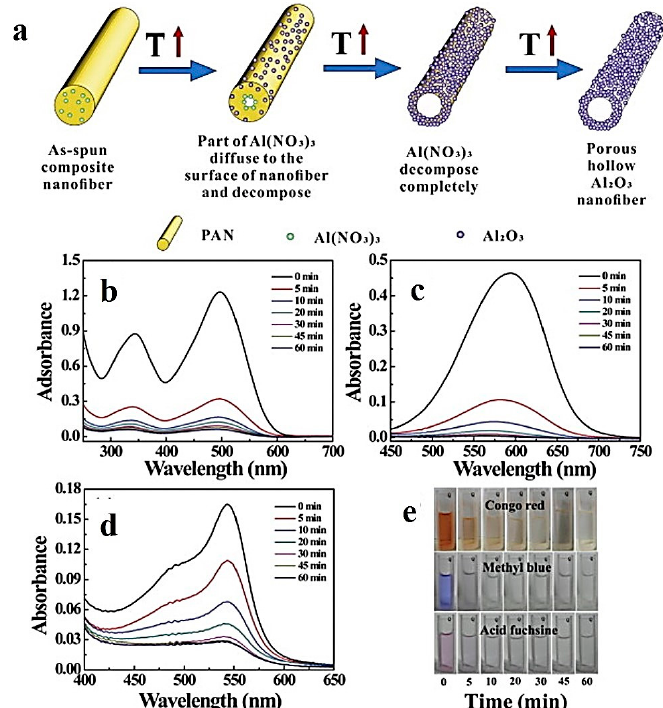
Figure 12. ( a ) The schematic shows different steps of the formation process of the porous hollow γ -Al 2 O 3 nanofibers; ( b – d ) UV–vis spectra of congo red (CR) ( b ) methylene blue (MB) ( c ), and acid fuchsine (AF) ( d ) in proximity of the porous hollow γ -Al 2 O 3 nanofibers after 0, 5, 10, 20, 30, 45, and 60 min, respectively. ( e ) Camera images of the dye solutions after exposure to the adsorbent at the mentioned time intervals (Reproduced with permission from [124]. Elsevier, 2017).